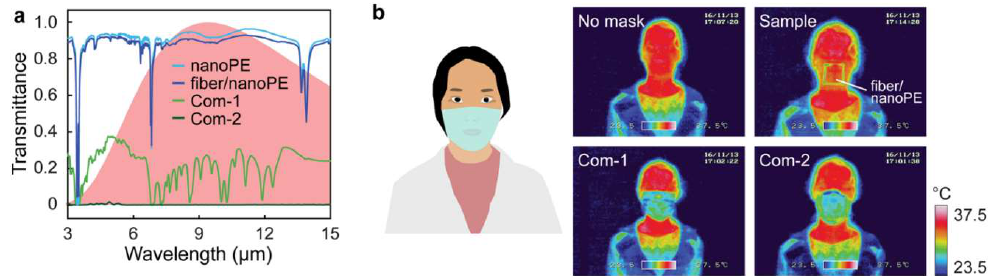
Figure 12. ( a ) FTIR spectra for nanoPE, fibre / nanoPE and two commercially available masks, ( b ) thermal imaging of a bare human face and face covered with the samples. Reproduced with permission from reference [107]. Copyright (2017), American Chemical Society.